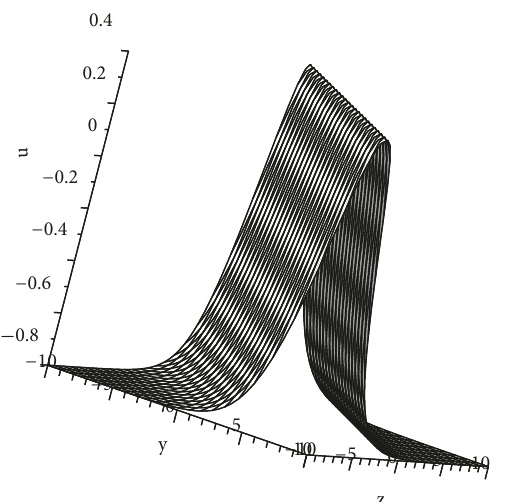
Figure 1: Solitary wave profile of 𝑢 3 , 𝛼 = 1 , 𝑑 = 0.5 , 𝑒 = 0.5 , 𝑐 = 0.6 , 𝑥 = 0 , and 𝑡 = 0 .